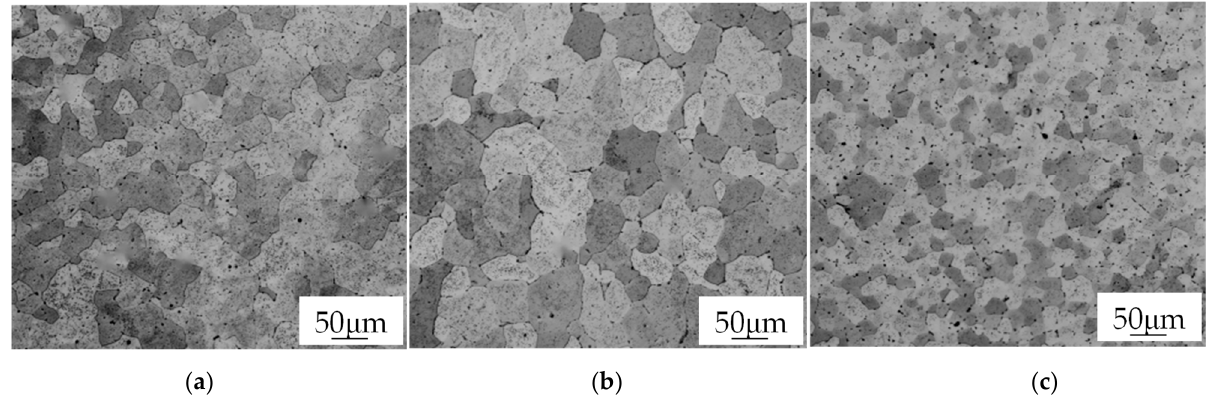
Figure 4. Microstructures of ZCL205A alloy deposits manufactured with different deposition pro- cesses held at 200 °C for 30 min. ( a ) Metallographic photo showing a specimen prepared using the CMT process; ( b ) metallographic photo showing a specimen prepared using the CMT and Pulse process; and ( c ) metallographic photo showing a specimen prepared using the CMT Pulse and Advanced process.